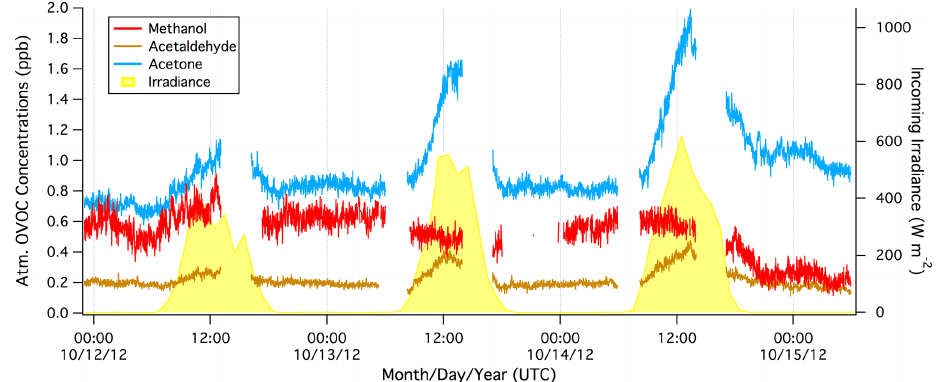
Figure 2. An example of contamination in the acetaldehyde and acetone signals due to outgassing from a plastic funnel at the front of the inlet. The artifact was the most severe under direct sunlight and at high temperatures, leading to unrealistic diurnal cycles. Methanol was not affected. This contamination disappeared immediately after the removal of the plastic funnel on 29